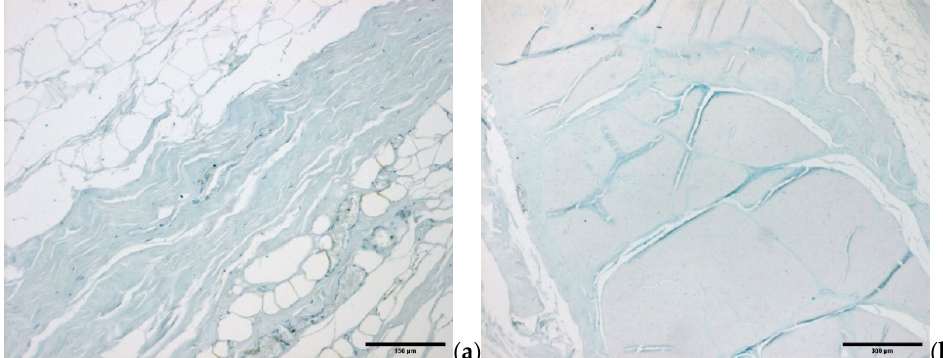
Figure 4. Alcian Blue/MgCl 2 0.05 M in sodium acetate buffer for glycosaminoglycans (GAGs) staining: ( a ) superficial fascia, ( b ) deep/muscular fascia.